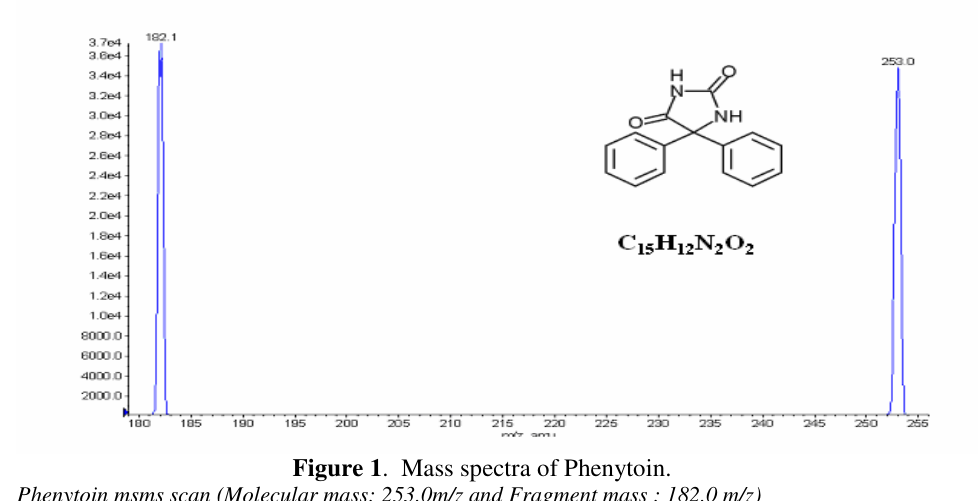
Figure 1 . Mass spectra of Phenytoin.